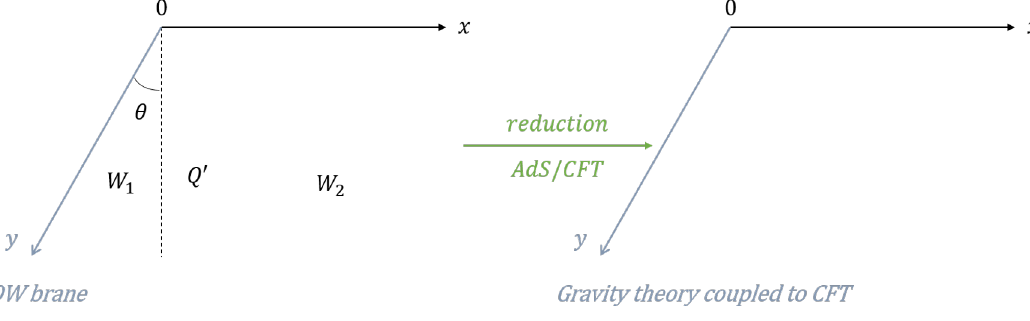
Figure 3 . Effective description with Neumann boundary